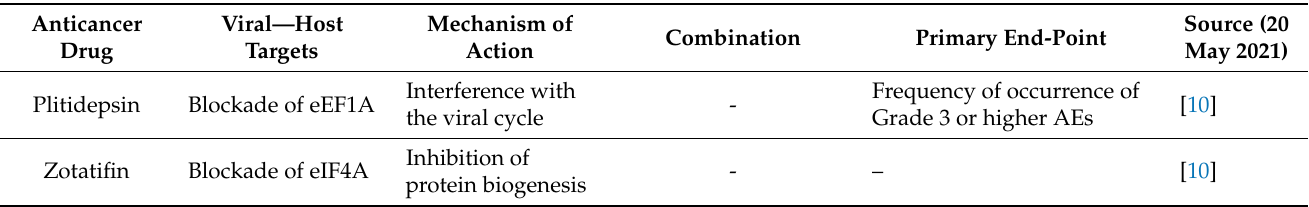
Table 5. Anticancer drugs in clinical trials for COVID-19: The inhibitor of elongation factor 1A and the eukaryotic initiation factor 4A.